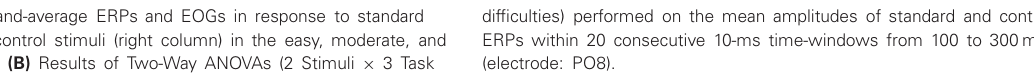
difficulties) performed on the mean amplitudes of standard and control ERPs within 20 consecutive 10-ms time-windows from 100 to 300ms (electrode: